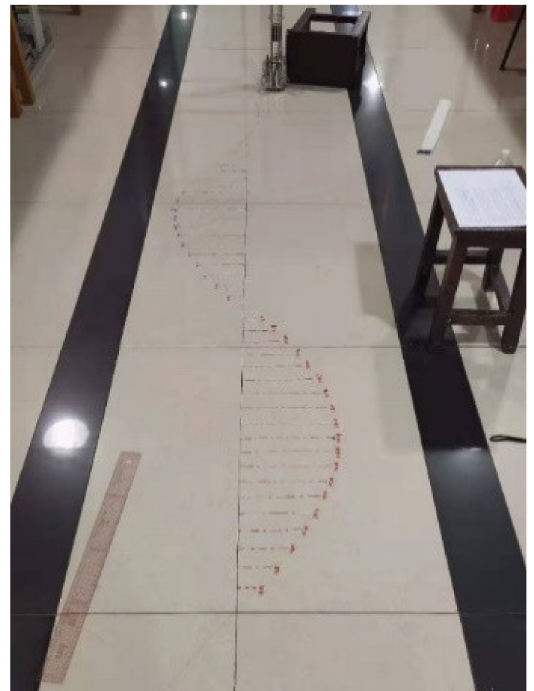
Figure 12. Trajectory